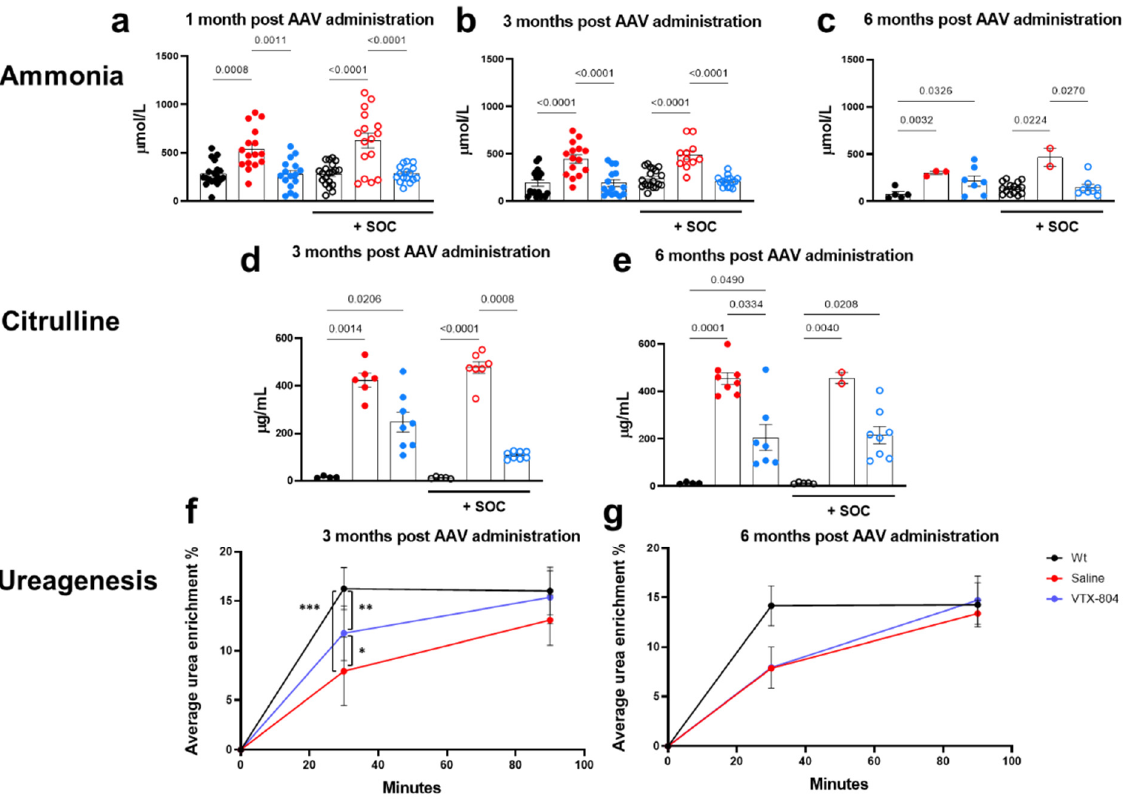
Figure 2. Serum ammonia and citrulline concentration and ureagenesis in wild-type and Ass1 fold mice. Ass1 fold mice treated with saline or VTX-804 vector at three weeks of age and wild-type mice were bled one, three and six months later to quantify ammonia ( a – c ) and citrulline ( d , e ) concentration. All three groups were also treated daily with nitrogen scavengers and arginine from birth to weaning (SOC) and SOC treated mice were used to assess urea production (ureagenesis) three and six months after vector administration ( f , g ). Ammonia groups of animals without SOC: WT mice (black closed circles; n = 19), saline treated Ass1 fold mice (red closed circles; n = 16), Ass1 fold treated with VTX-804 vector (blue closed circles; n = 16). Ammonia groups of animals with SOC: WT mice (black open circles; n = 19), saline treated Ass1 fold mice (red open circles; n = 16), Ass1 fold treated with VTX-804 vector (blue open circles; n = 16). Half of the mice were sacrificed 3 months after vector administration and consequently the six months Wt and VTX-804 groups were composed of less animals. Citrulline groups of animals without SOC: WT mice (black open circles; n = 4), saline treated Ass1 fold mice (red open circles; n = 6 [3 months p.i.] and n = 8 [6 months p.i.]), Ass1 fold treated with VTX-804 vector (blue open circles; n = 8 [3 months p.i.] and n = 7 [6 months p.i.]). Ureagenesis groups of animals: WT mice (black open circles; n = 9 [3 months p.i.] and n = 8 [6 months p.i.]), saline treated Ass1 fold mice (red open circles; n = 10 [3 months p.i.] and n = 2 [6 months p.i.]), Ass1 fold treated with VTX-804 vector (blue open circles; n = 8). WT mice (black circles; n = 4), saline treated Ass1 fold mice (red circles; n = 6 [3 months p.i.] and n = 8 [6 months p.i.]), Ass1 fold treated with VTX-804 vector (blue circles; n = 8 [3 months p.i.] and n = 7 [6 months p.i.]). Only p values < 0.05 are shown (one-way and